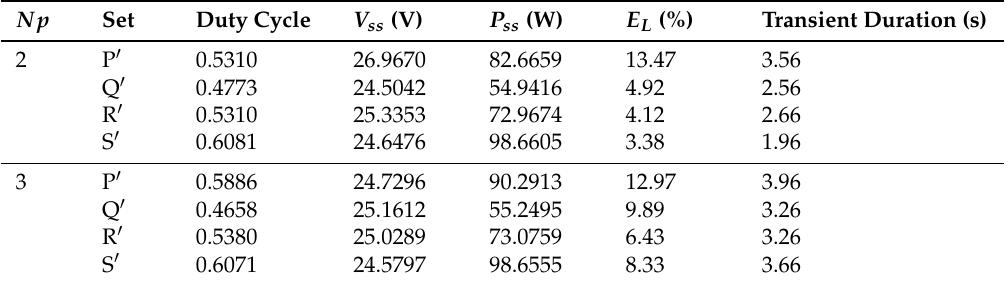
Table 10. Performance comparison of Improved Particle Swarm Optimization (IPSO) method under partial shading when Np = 2 and Np = 3.